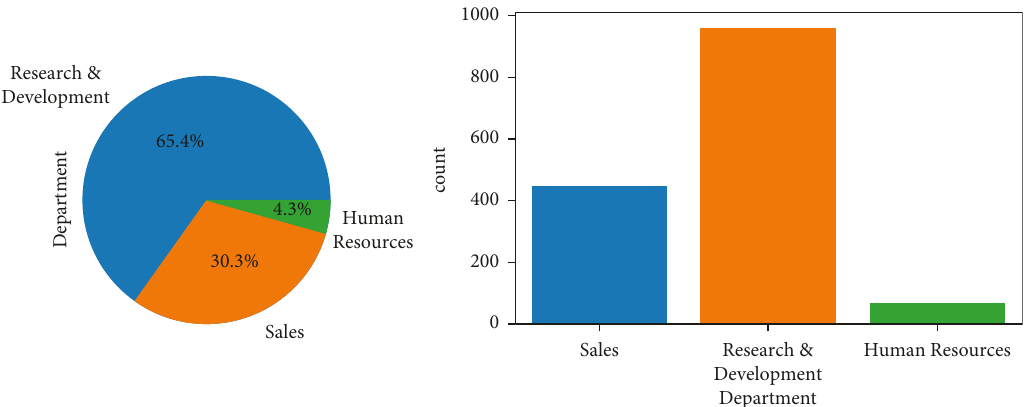
Figure 5: Attrition on the basis of the department of employees.